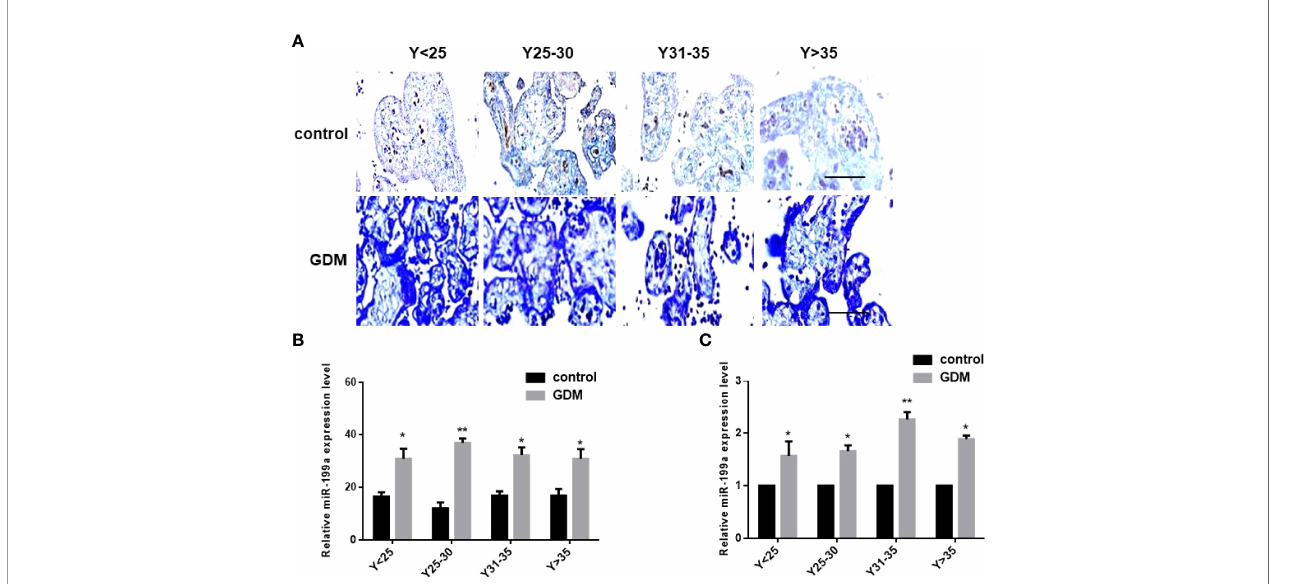
FIGURE 1 | The expression of miR-199a is up-regulated in the placenta of GDM patients. (A, B) In situ hybridization of miR-199a-speci fi c DIG-labeled LNA probes to detect the localization and expression of miR-199a in the placenta. (C) Real-time PCR detection of miR-199a expression in placenta. n=10. The scale bar indicates a distance of 1000 m m. * P <0.05; ** P <0.01.